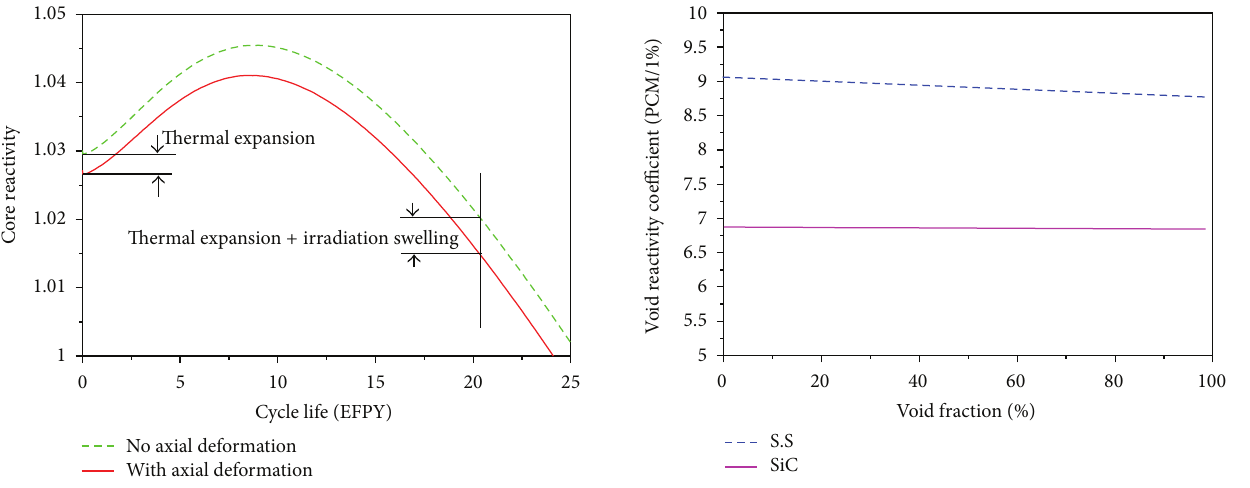
Figure 18: Influence of SiC f /SiC on void reactivity.